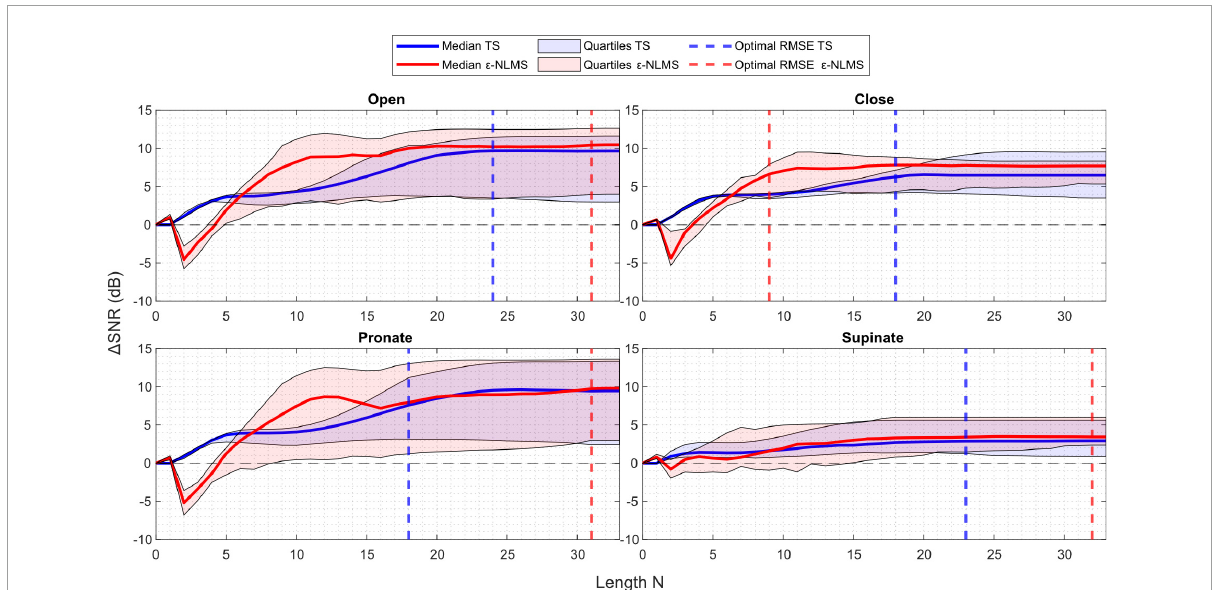
FIGURE5 (cid:49) SNR generally improved with an increasing length N for Template Subtraction (TS) (blue), however ε -Normalized Least Mean Squares ( ε -NLMS) (red) required a minimum length be met before improvement was seen. Variability of the outcome (shaded region) did not appear to relate to the length N, nor did the value determined via parameter optimization (dashed vertical lines) consistently align with the maximum (cid:49) SNR.